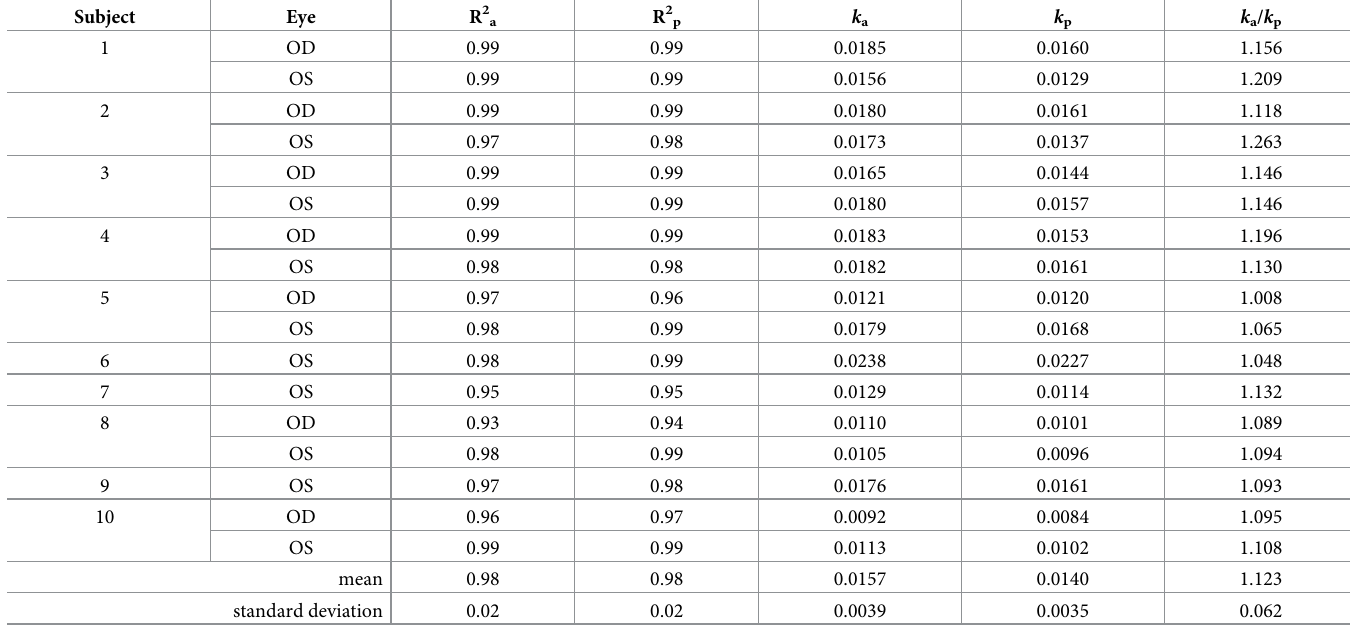
Table 2. Approximation of axial stiffness from the slope term of the force/displacement relationship for anterior and posterior corneal stroma.